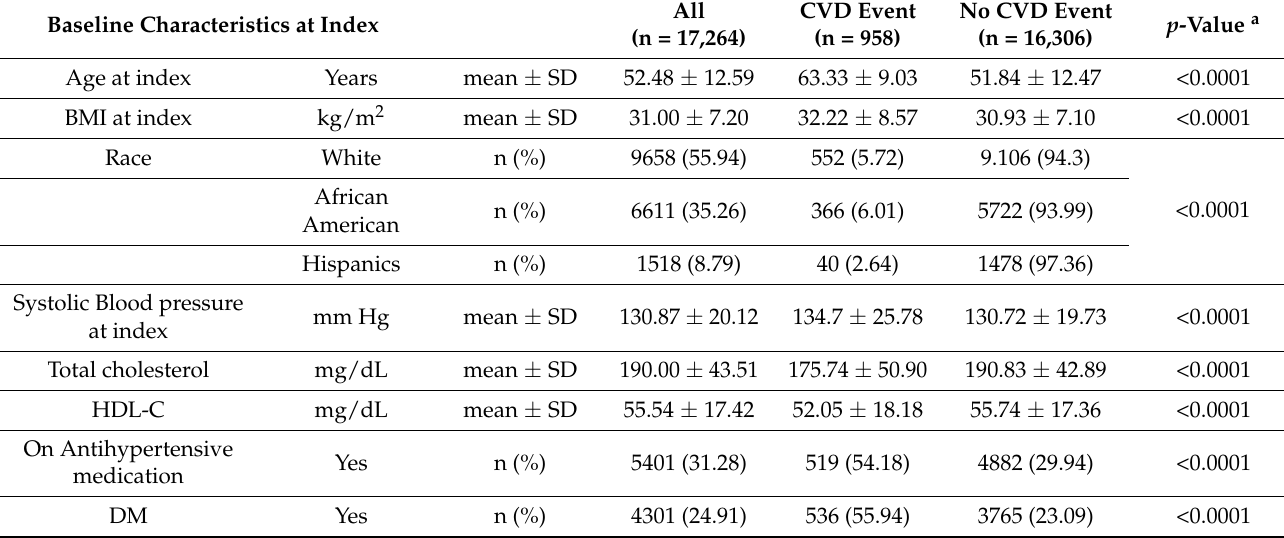
Figure 1. Receiver operating characteristics (ROC) curves of the model and CVD risk score for three race and ethnic groups. ( a ) White women veterans; ( b ) African American women veterans; ( c ) Hispanic women veterans. Notes: blue lines represent ROC curves for the model and red dashed lines for CVD risk score. Numbers in parentheses represent areas under the ROC curves. A 45-degree line represents 50% accuracy. Table 1. Baseline characteristics of veteran women by cardiovascular disease (CVD) event 60 days after COVID-19 testing. Baseline Characteristics at